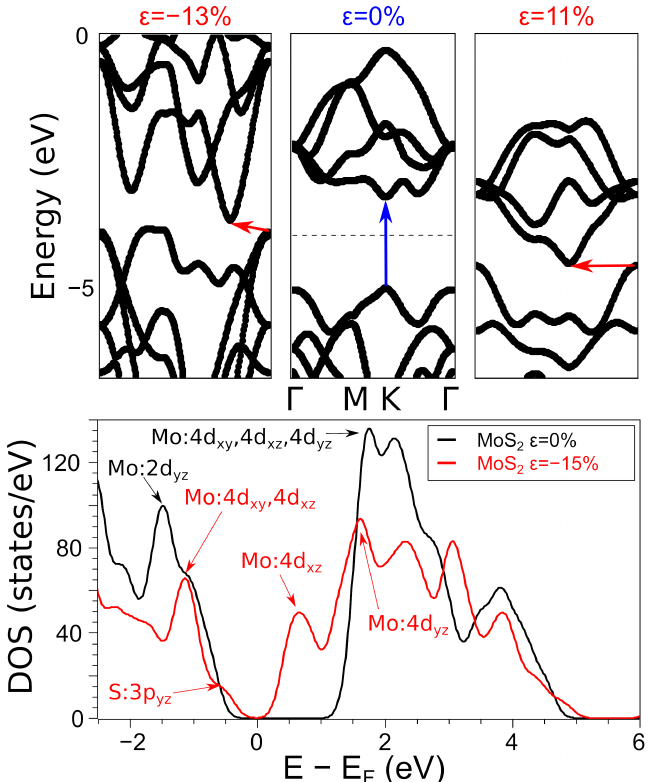
Figure 2. Band structure for three different strain levels. The units of the y -axis are eV. The dashed line in the middle panel represents the fermi energy, E F . Lower panel shows the Density of States of pristine and compressed MoS 2 . Arrows indicate the major contributor orbitals for both